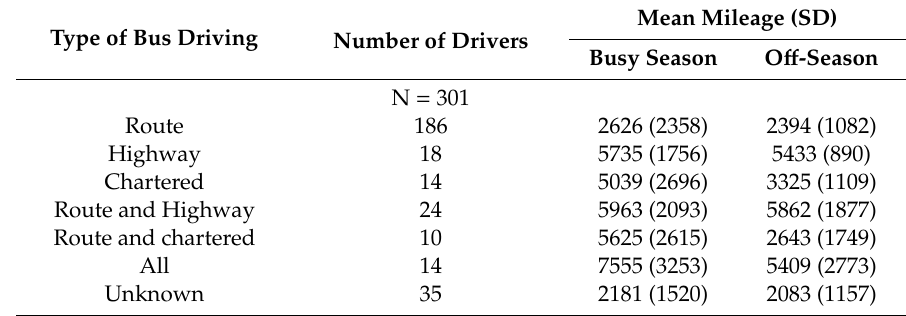
Table 1. Average travel distance (km / month) by the type of bus